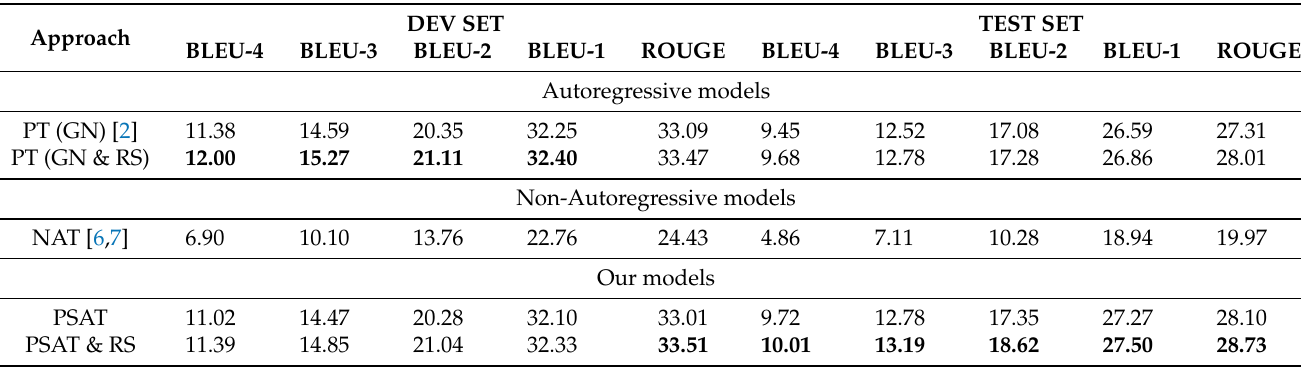
Table 2. Comparison of the performance with state-of-the-art models on RWTH-PHOENIX-Weather- 2014T.